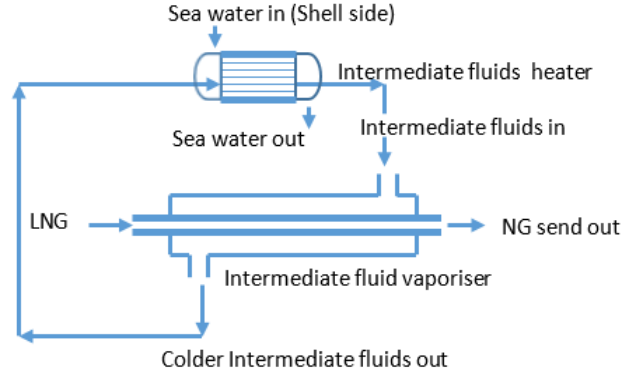
Figure 6. Intermediate fluid vaporizer.